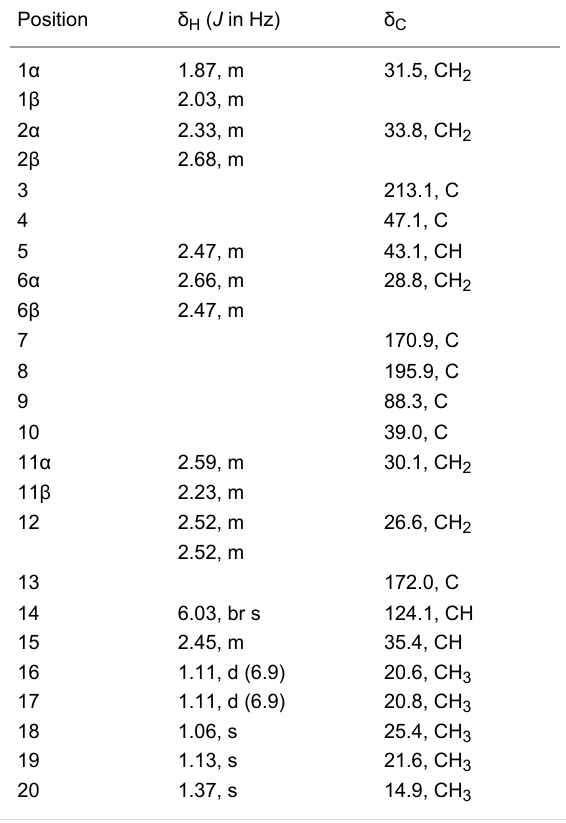
Table 1: 1 H (400 MHz) and 13 C (100 MHz) NMR spectroscopic data for 1 in CDCl 3 ( δ